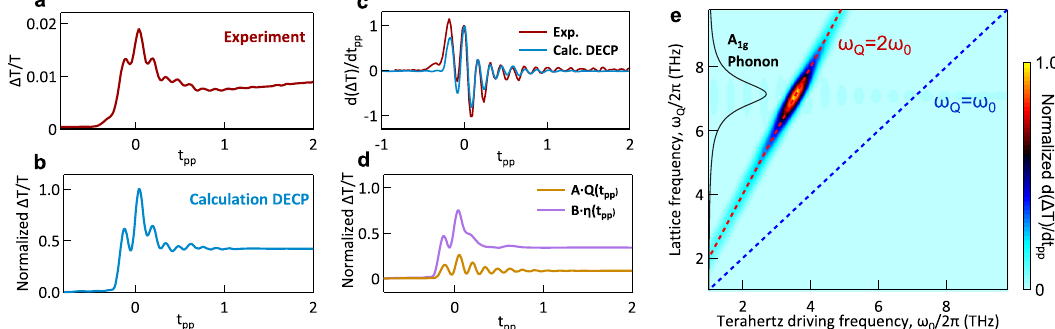
Fig. 3 Modelling of terahertz displacive excitation of phonons. a Experimental data at 300 K and b , numerical calculation using Eq. (3) using phononic and electronic parameters of V 2 O 3 at 300 K. c Comparison of the time derivative of the dynamics: experimental data (red curve) and numerical calculation (light blue curve), both normalized to the value at t pp = 0. d Calculated electronic (blue curve) and lattice (red curve) contributions to the Δ T / T dynamics from Eq. (3). The electron dynamics show no signature of long lived oscillatory components. e Time-derivative of the lattice dynamics Q ( t ) in frequency domain calculated by displacive excitation of coherent phonons (DECP) model [Eq. (2)] as a function of the center frequency ω 0 /2 π of the driving THz fi eld. Temporal derivative is shown to emphasize the oscillatory component over the slowly-varying background. The phonon amplitude is maximum when Ω = 2 ω ω π . 0 . The black curve is the A 1 g phonon lineshape as a function of the lattice frequency Q /2 Δ T / T ( t fi eld shown in pp ) by using the experimental THz driving Fig. 1c and the following A 1 g phonon parameters Ω /(2 π ) = 7.1 THz, γ /(2 π ) = 0.5 THz obtained by Raman spectroscopy (see Supple-